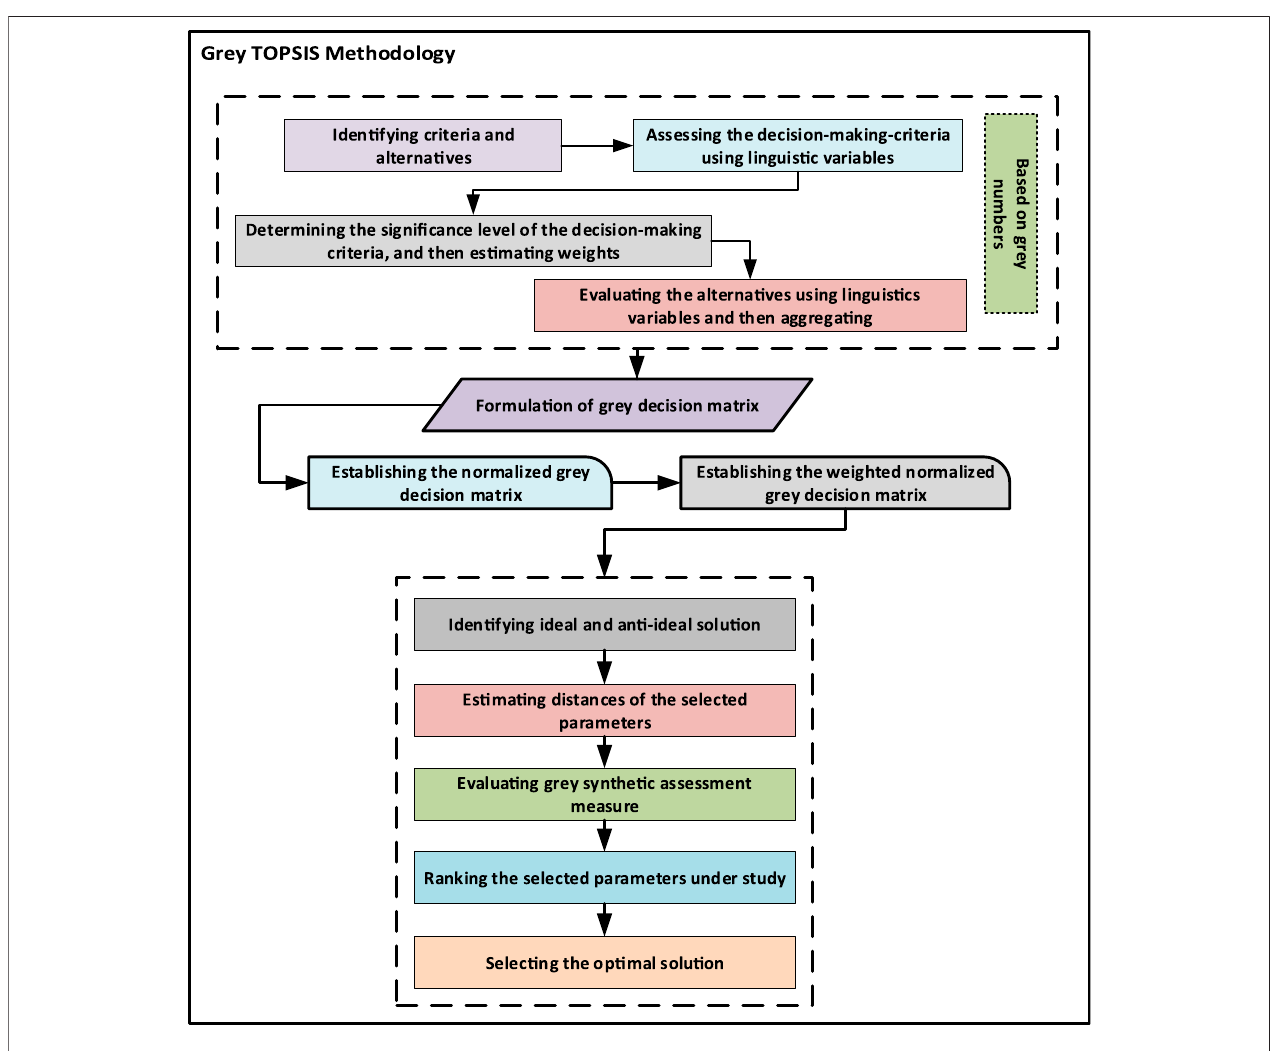
FIGURE 3 | The framework of proposed grey-based TOPSIS.